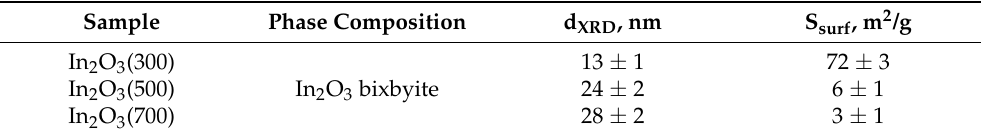
Figure 2. X-ray diffraction patterns ( a ) and Raman spectra ( b ) of nanocrystalline In 2 O 3 samples. Table 2. Phase composition, crystallite size (d XRD ) and specific surface area (S surf ) of nanocrystalline In 2 O 3 samples annealed at temperatures of 300, 500 and 700 ◦